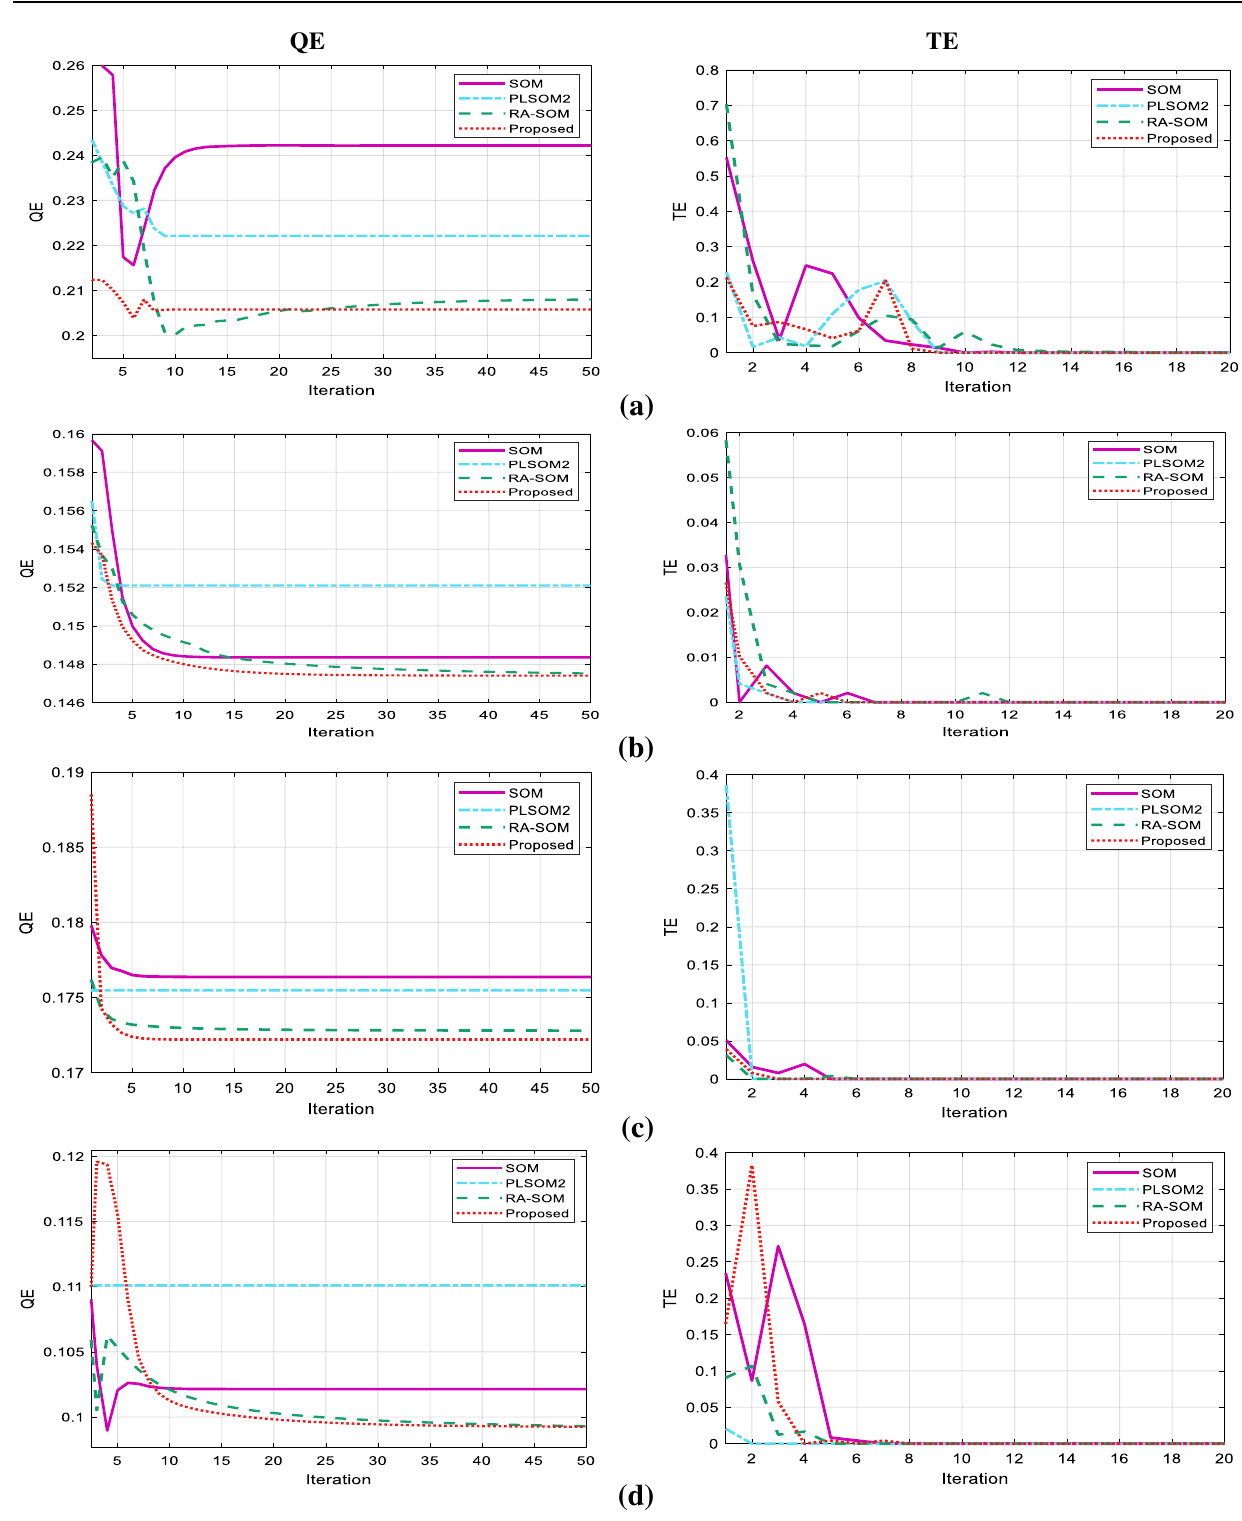
Fig. 7 The comparison of learning behavior between conventional SOM, PLSOM2, RA-SOM and proposed VLR-SOM for each dataset: a Balance b Wisconsin c Dermatology and d